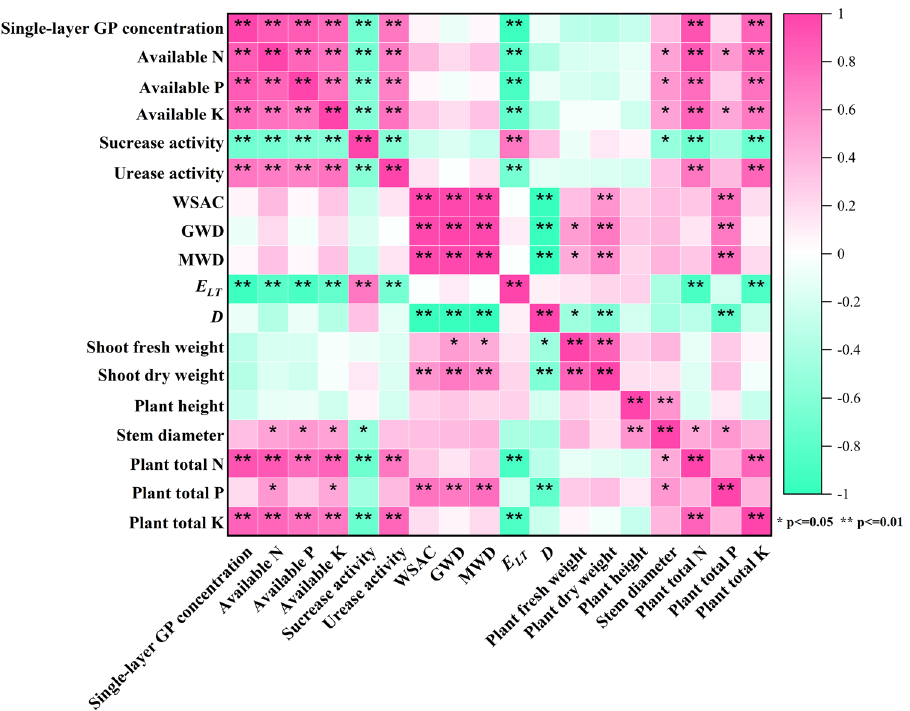
Figure 5. Correlation analysis among the indicators of single-layer graphene